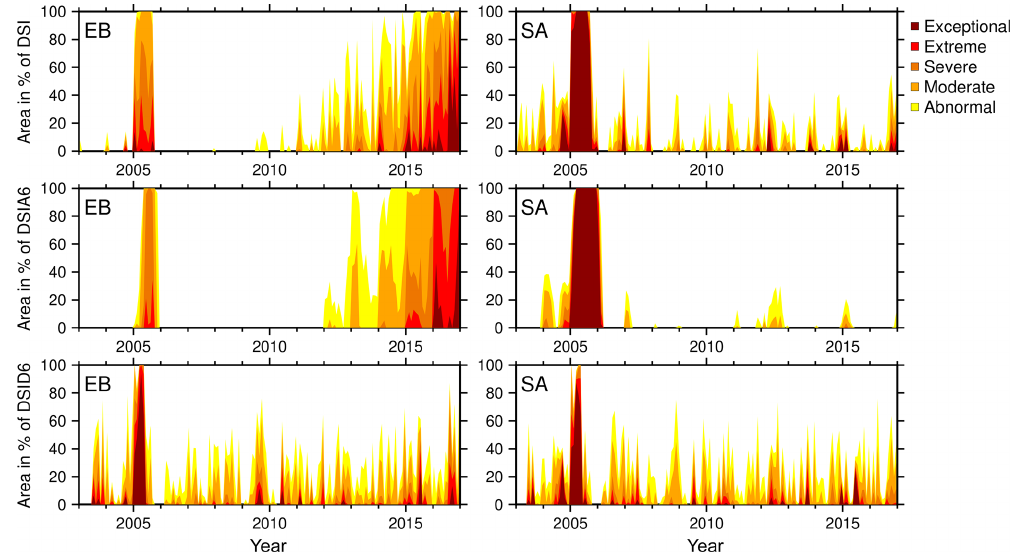
Figure 10. Drought-affected area of the DSI, DSIA, and DSID (%) considering the different drought severity classes within the clusters of eastern Brazil (EB) and southern Africa (SA).